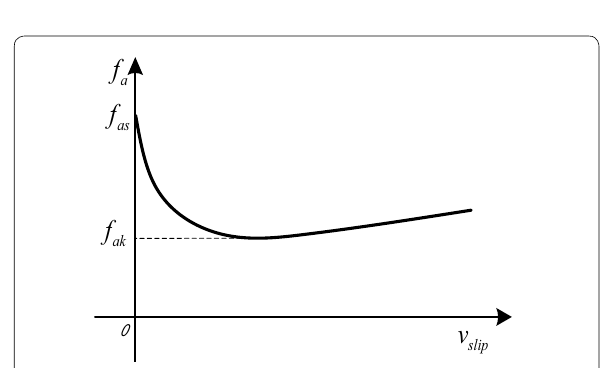
Figure 6 Stribeck curve ( f ak is the dynamic friction coefficient, f as is the maximum static friction coefficient, v slip is the relative sliding